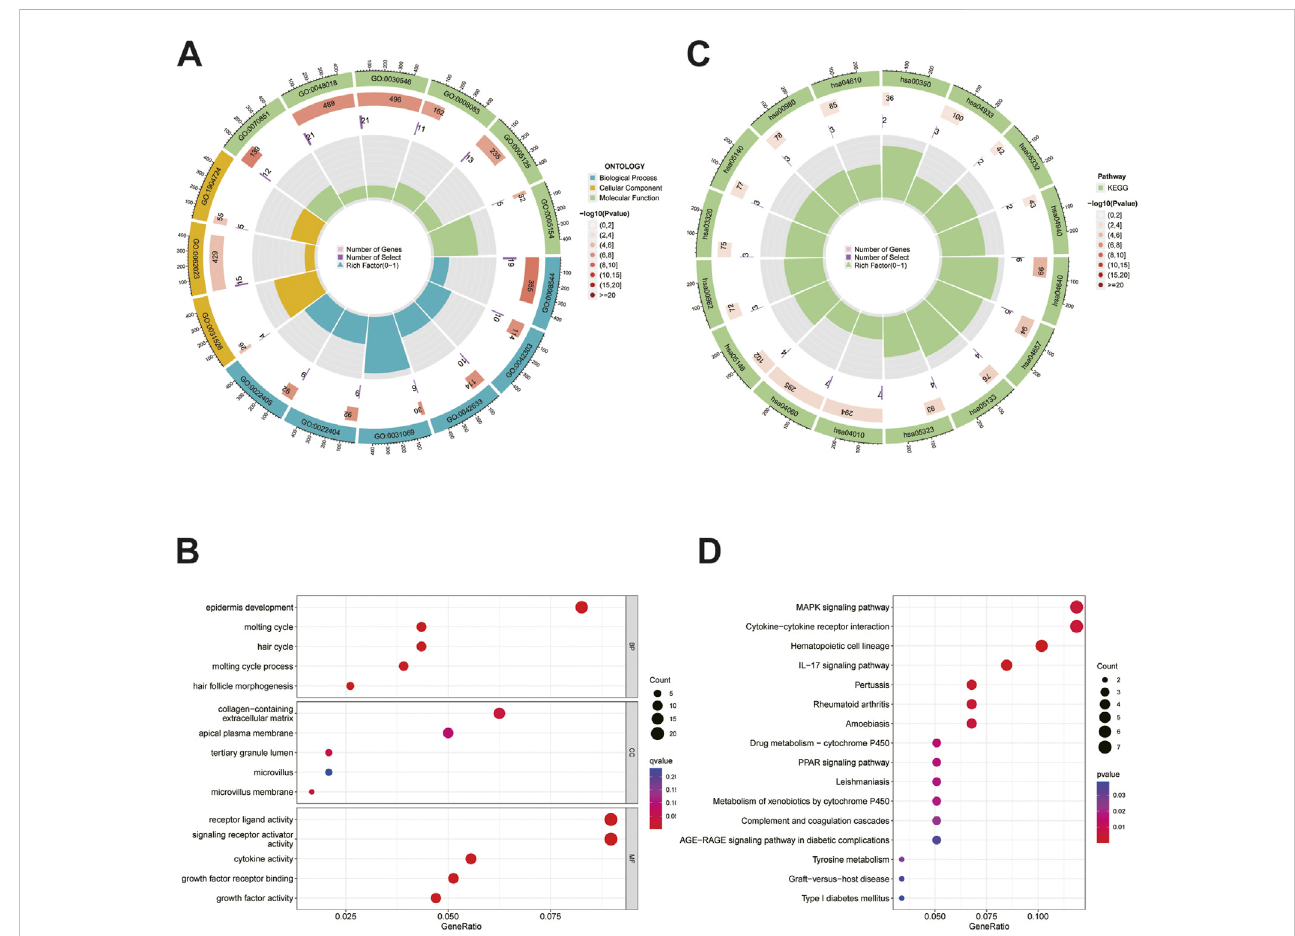
FIGURE 6 GO and KEGG analysis. (A) The circle graph of GO analysis. (B) The bubble diagram of GO analysis. (C) The circle graph of KEGG analysis. (D) The bubble diagram of KEGG analysis.